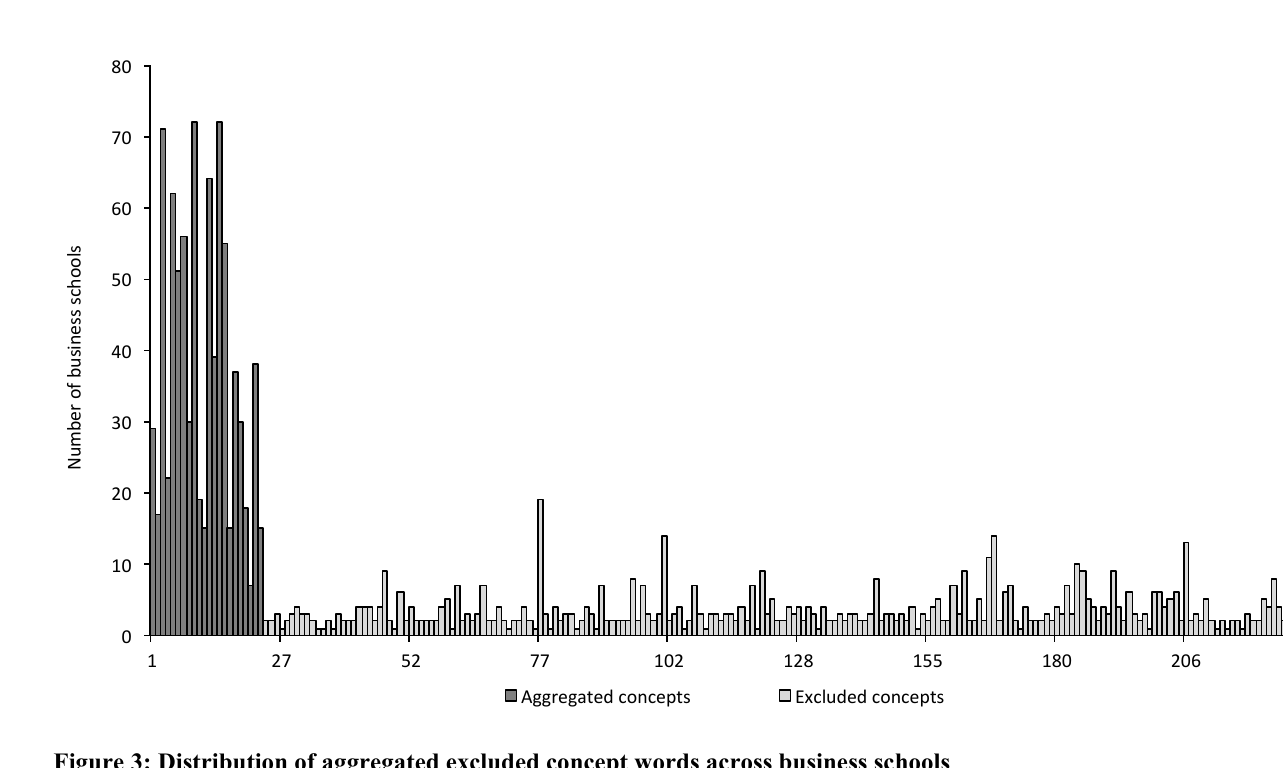
Figure 3: Distribution of aggregated excluded concept words across business schools The results from the Marascuilo (1966) comparison of multiple proportions test are shown in Table 3. The first